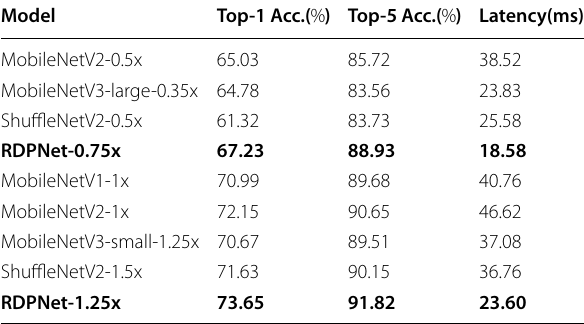
Table 3 after we scale the network width to create models with 6 specifications and validate them.